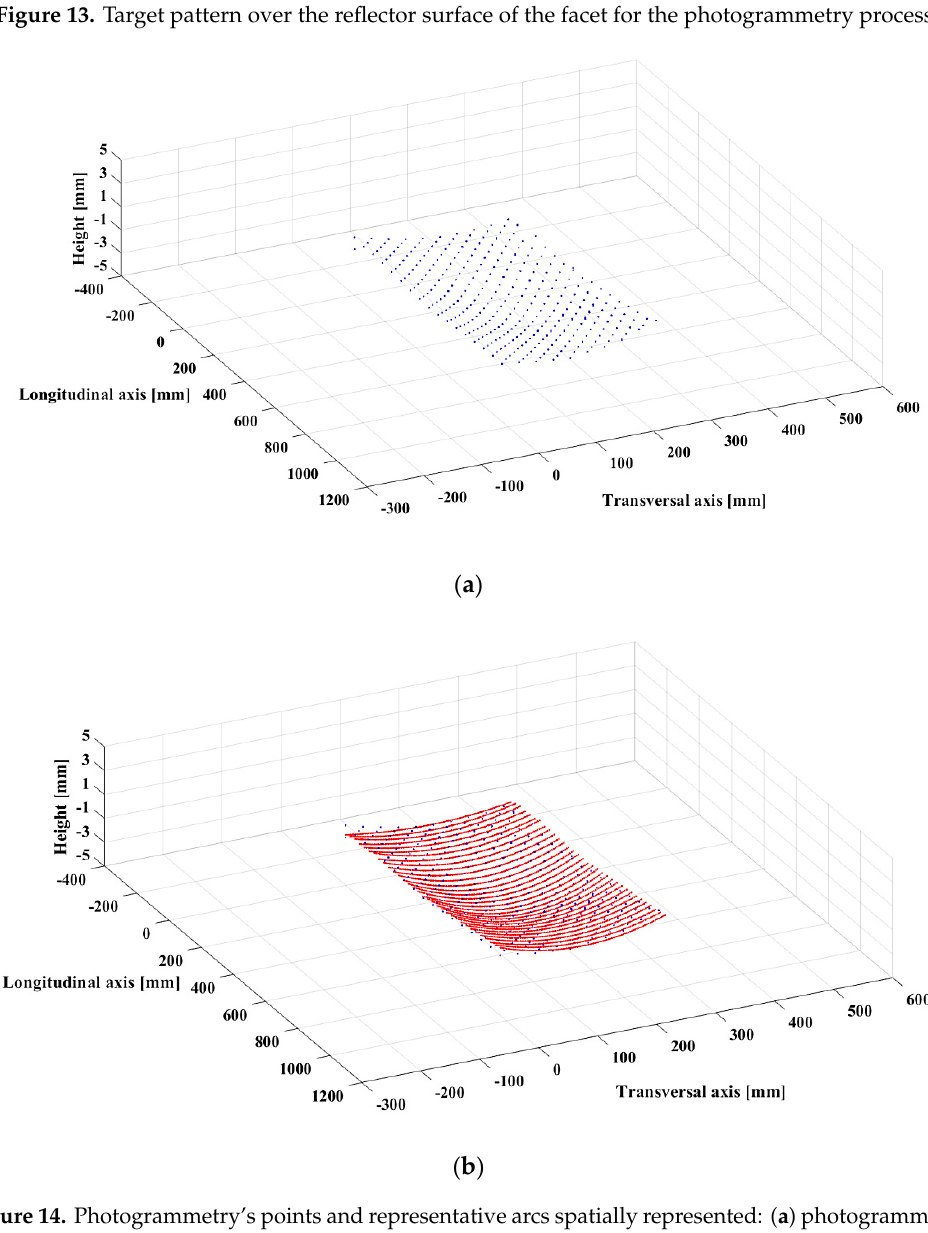
Figure 14. Photogrammetry’s points and representative arcs spatially represented: (a) photogrammetry points and (b) representative arcs.